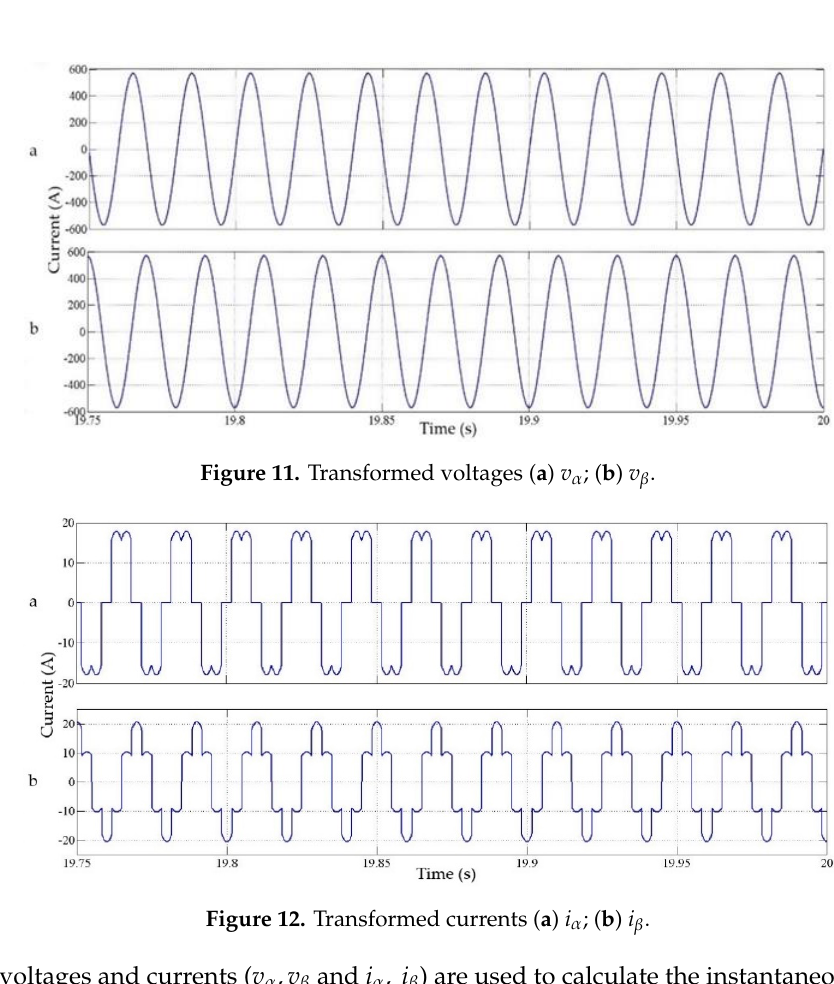
Figure 10. Simulink model of the Clarke transformation ( a ) voltage transformation; ( b ) current transformations.